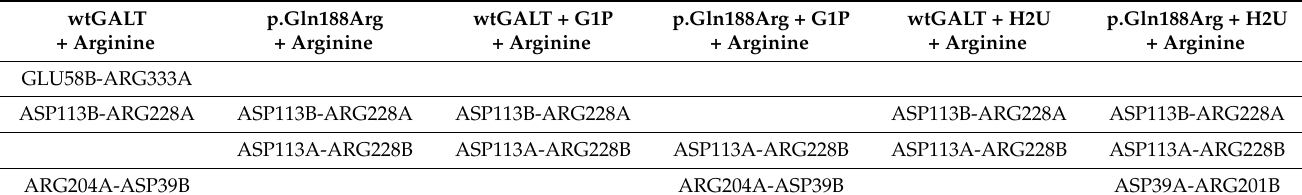
Table 3. Couples of residues involved in stable intersubunit salt bridges in simulations with arginine in the active site. Couples of residues are considered to have a stable salt bridge interaction when the sum of % of existence of the salt bridges between the two residues is ≥